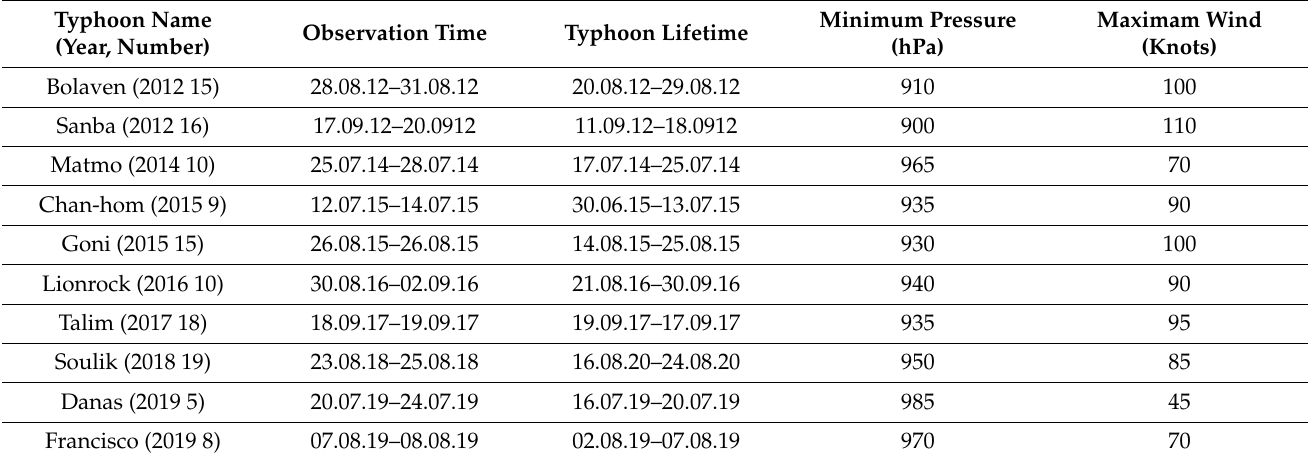
Table 1. Characteristics of typhoons.